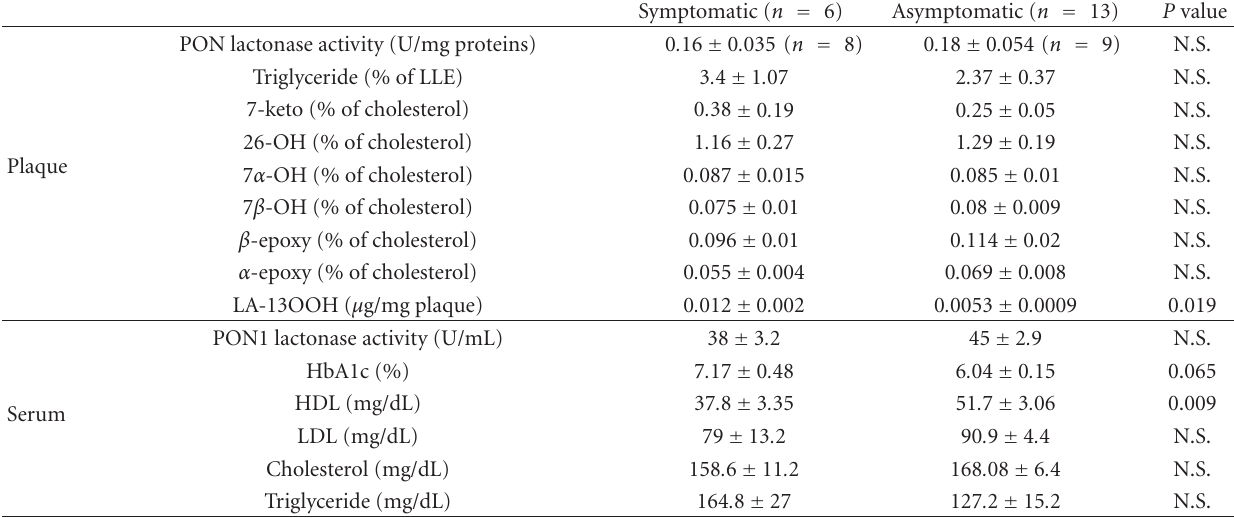
Table 2: Atherogenic and antiatherogenic elements in the plaques and blood of symptomatic and asymptomatic patients.